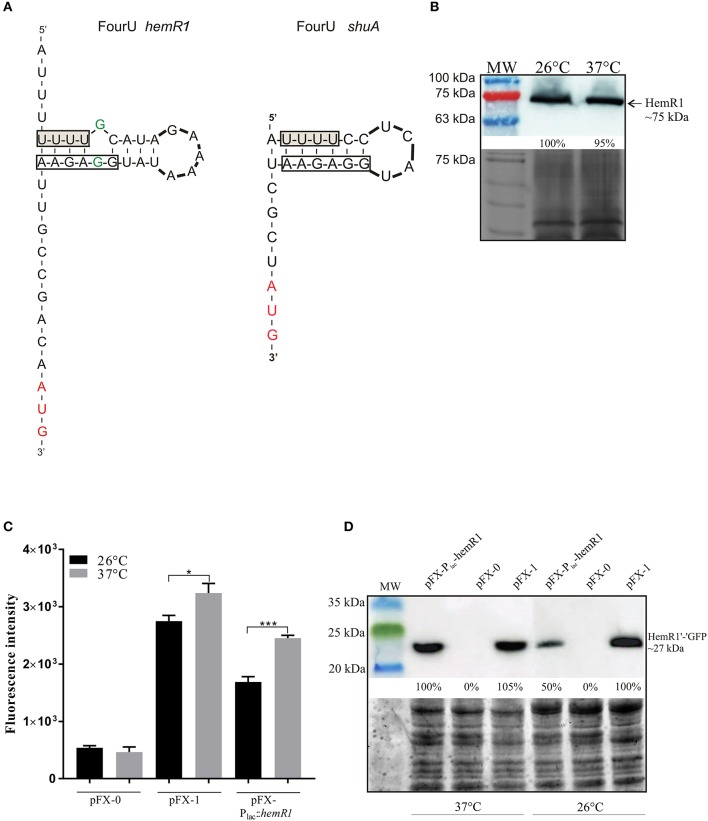
Influence of temperature on hemR1 expression. (A) Potential FourU thermometer RNA secondary structures in the 5′-UTRs of Y. enterocolitica Ye9 hemR1 and S. dysenteriae shuA, composed of a stretch of FourU and the ribosomal binding site (RBS), revealed by Mfold analysis (http://mfold.rna.albany.edu). Boxes indicate the location of the FourU motif (shaded) and putative RBS, the translation start codon is marked red, and unpaired nucleotides within the predicted secondary structure are in green. (B) Temperature-dependent HemR1 expression in Y. enterocolitica examined by immunoblotting. The analyzed samples were cell lysates of the fur mutant grown at 26 or 37°C in LB medium. The top panel shows the Western blot probed with a polyclonal antibody against HemR1, the bottom panel shows the Coomassie blue-stained gel as a loading control. The percentage values on the blot, indicating the HemR1 band intensities relative to that of cells grown at 26°C, were determined using Amersham Imager 600 Analysis Software V1.0.0 (GE Healthcare). (C) Expression of a hemR1′-′gfp translational fusion at different temperatures, monitored by fluorescence intensity. E. coli BW25113 harboring the reporter plasmid pFX-Plac-hemR1 or control plasmids pFX-0 and pFX-1 were grown in LB medium at 26 or 37°C. The GFP fluorescence intensity (RFU) of overnight cultures was determined. The data represent the averages ± SD from at least three experiments with duplicate cultures. Significance was calculated using one-way ANOVA [P > 0.05, *P < 0.05, ***P < 0.001]. (D) GFP abundance examined by immunoblotting. The analyzed samples were cell lysates of E. coli BW25113 harboring the plasmids pFX-0, pFX-1 or pFX-Plac-hemR1. The top panel shows the immunoblot probed with antibody against GFP, the bottom panel shows the TGX Stain-Free gel as a loading control. MW, 3-Color Prestained Protein Marker; kDa. These results are representative of at least three independent experiments.